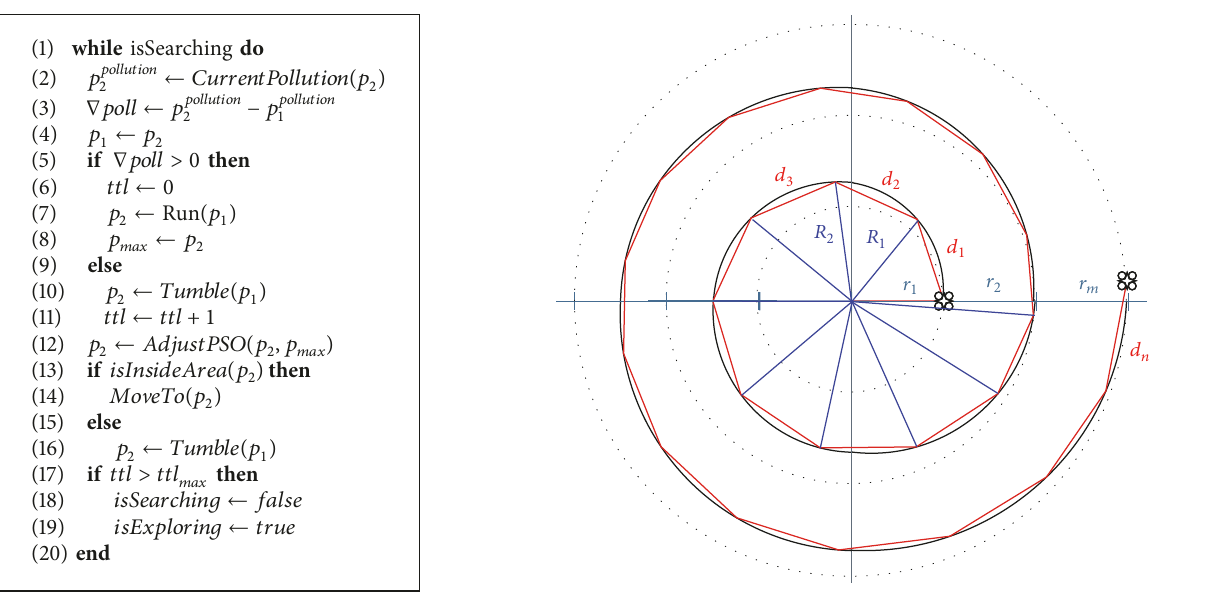
Figure 5: PdUC algorithm: exploration